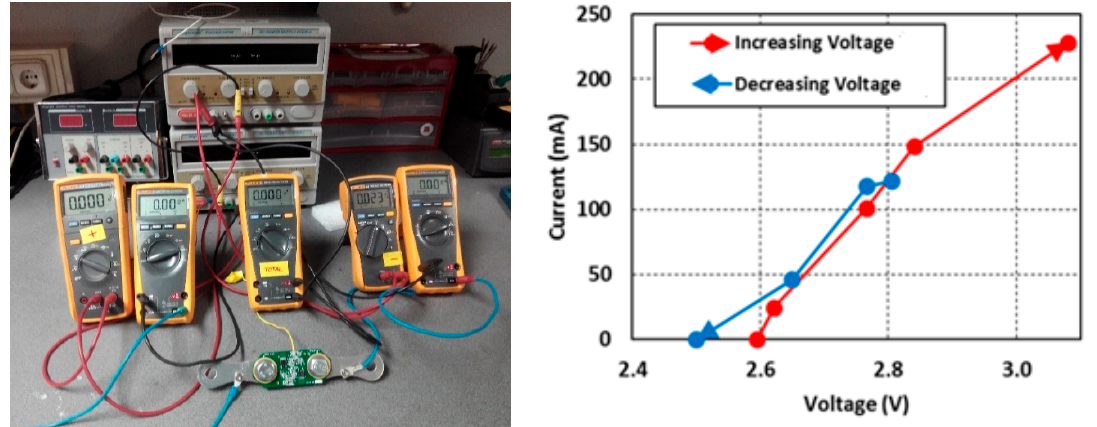
Figure 11. Experimental test to measure the current through the active balance circuit when the voltage in the cell is above 2.6 V.